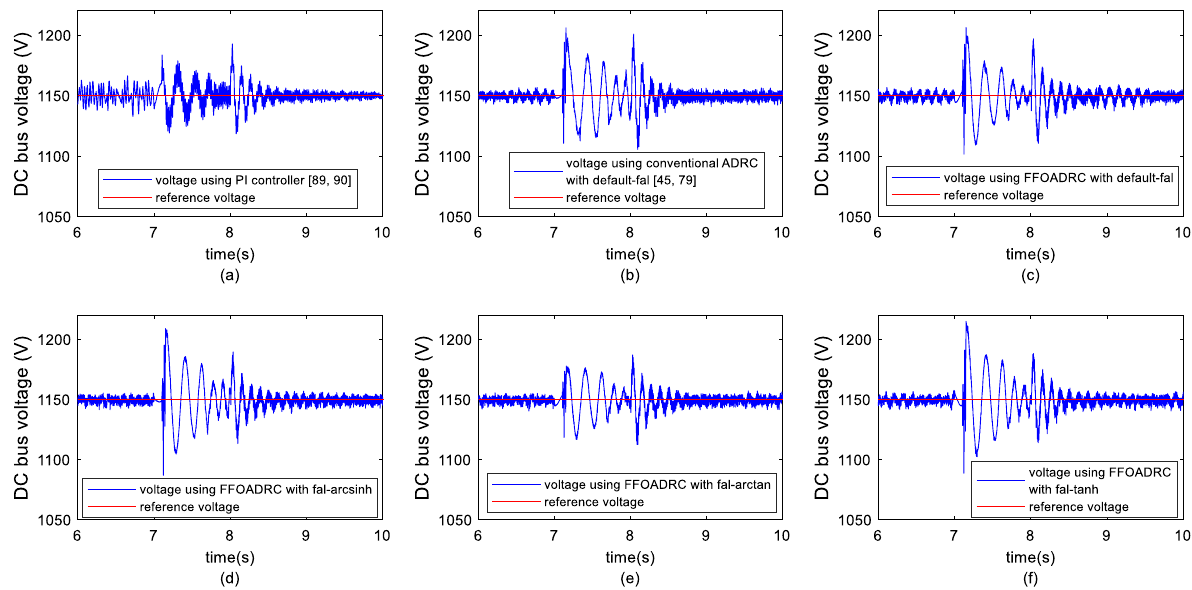
Fig. 20 DC bus voltage of the DFIG during symmetrical voltage sag: ( a ) PI controller [89, 90], ( b ) Conventional ADRC with default-fal [45, 79], ( c ) FFOADRC with default-fal, ( d ) FFOADRC with fal-arcsinh, ( e ) FFOADRC with fal-arctan, and ( f ) FFOADRC with